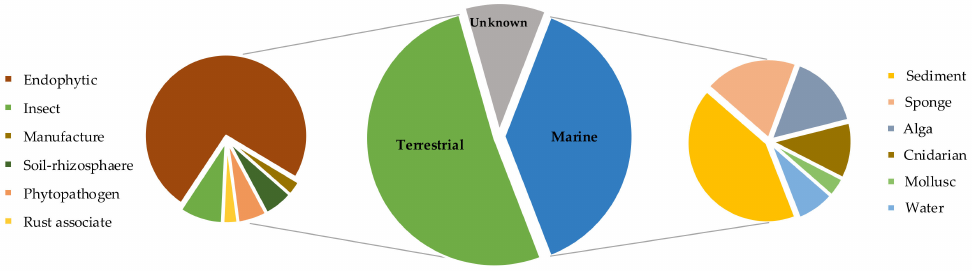
Figure 1. Pie charts of the origin of the strains examined in the present review. Despite the low number of strains, a long list of products has been reported from Cladosporium , starting with the finding of cladosporin in 1971 [12]. In fact, from anal- ysis of the available literature, a total of 244 chemically defined compounds can be ex- tracted, belonging to different classes of secondary metabolites, such as azaphilones, benzofluoranthenones, coumarins and isocumarins, lactones, naphthalenones, macrolides, perylenequinones, sterols and others (Table 2). Of course, this list includes both known metabolites and compounds, which have been first characterized from these fungi, with the latter representing a remarkable share (147, corresponding to about 60%). In our sur- vey, we avoided considering some products that are known intermediates in biosynthetic processes, clearly represent possible contaminants of the fungal cultures, or were just tentatively identified [13–21]. Table 1. Cladosporium species/strains reported for production of secondary